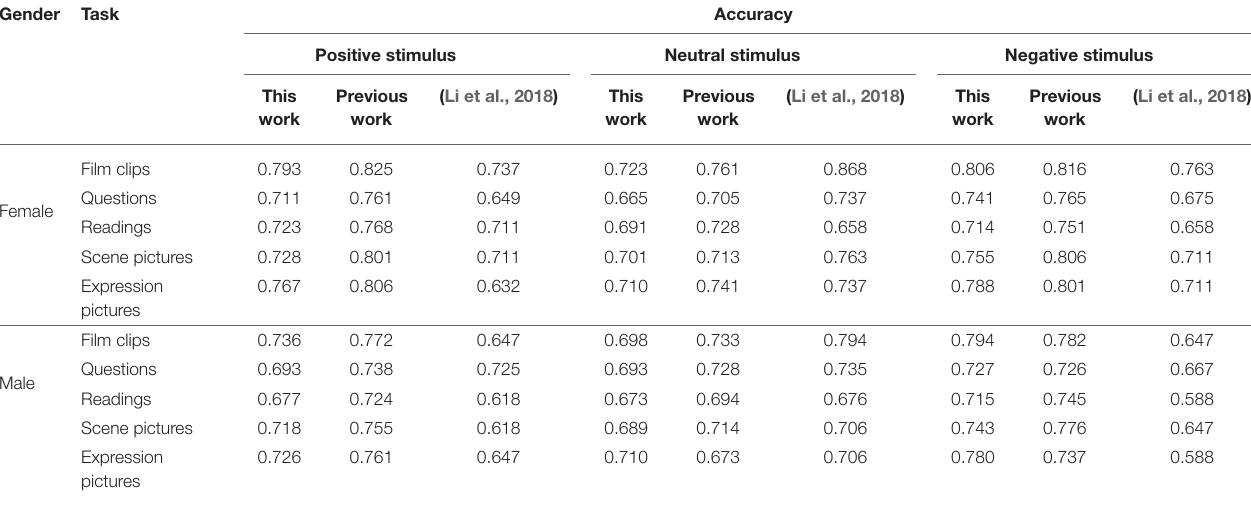
TABLE 4 | Comparison of accuracy based on the same database. Gender